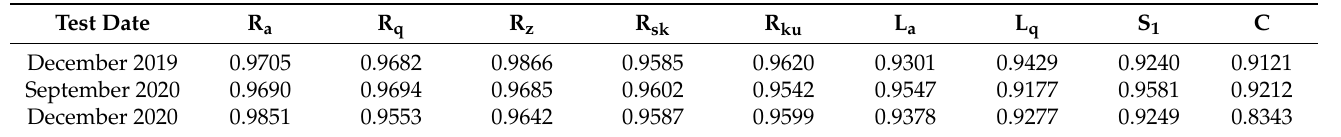
Table 4. Grey entropy correlation degree at different pavement service times between different macro-texture indexes and F 60